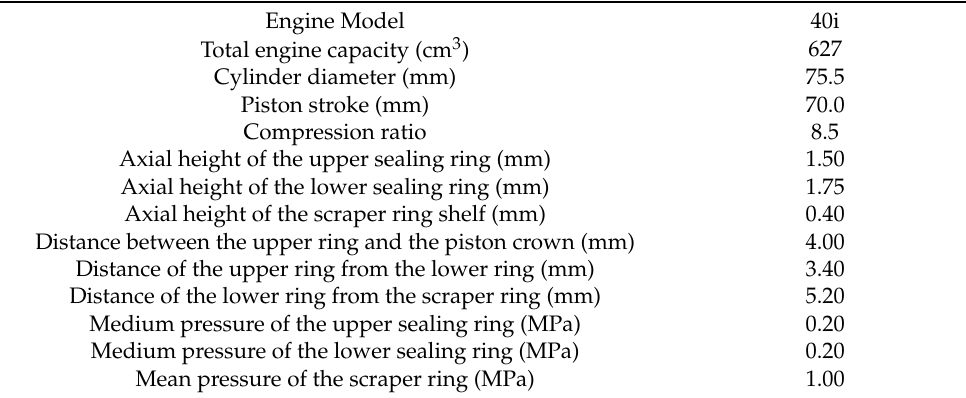
Table 1. Technical Data of the Aircraft Internal Combustion Piston engine Intended for the Bench